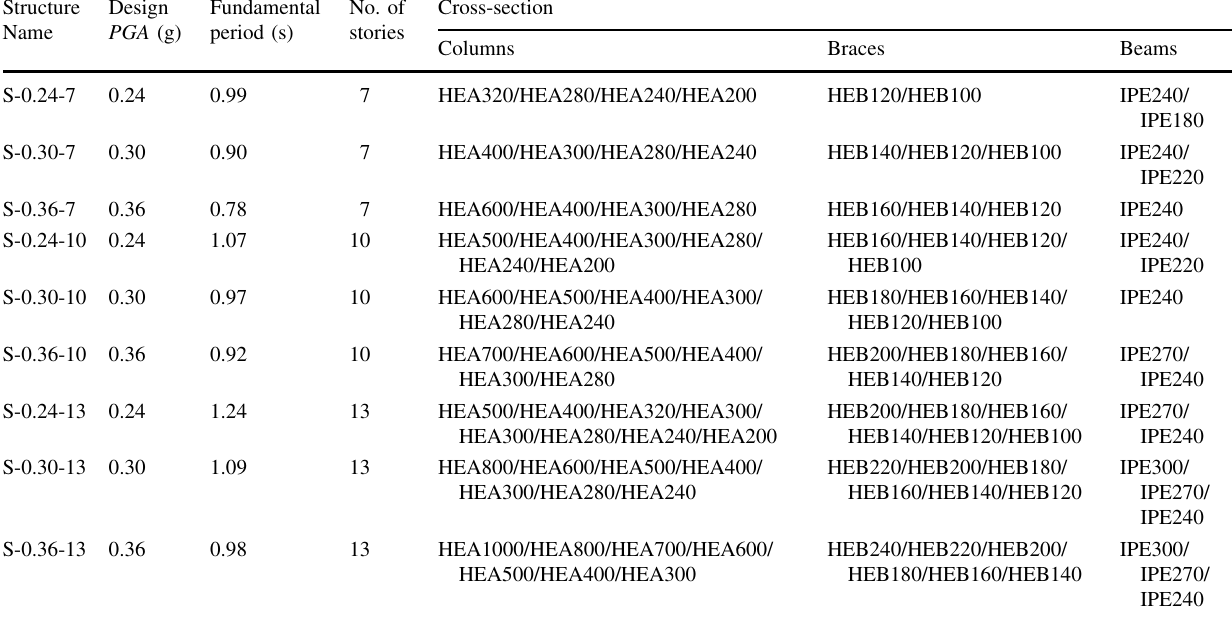
Table 2 Characteristics of the analyzed nine steel (S) structures in Bucharest,